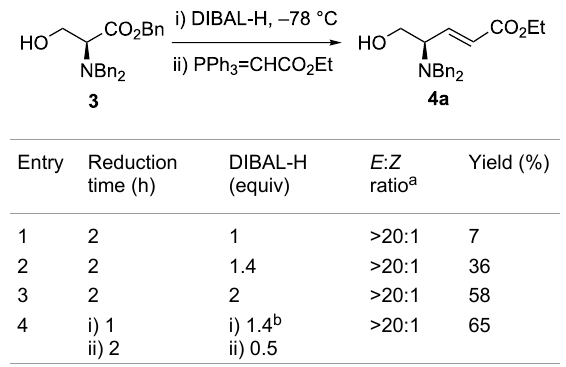
Table 3: Screening of the reaction conditions for the one-pot tandem reduction–olefination of free hydroxyserine derivatives.